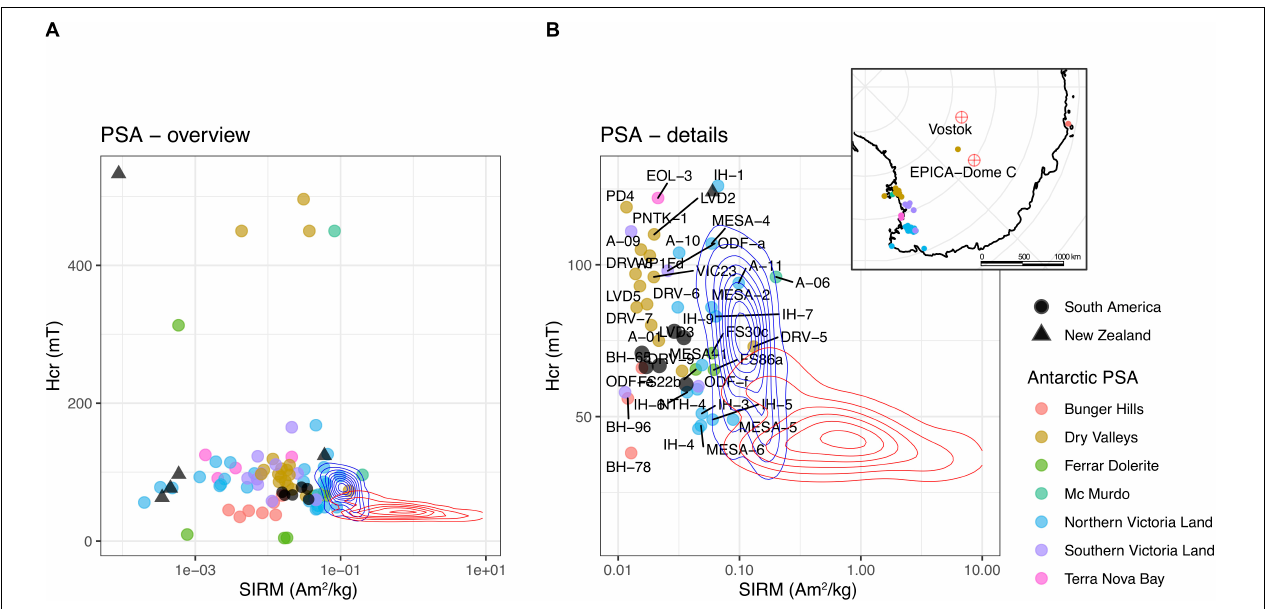
FIGURE 6 | Magnetic properties of PSA samples in the semi-logaritmic SIRM/H cr diagram. The SIRM dust data from ice cores, including the dataset from Lanci et al. (2008a), are reported for comparison using their distribution density estimates computed according to Venables and Ripley (2002). SIRM dust data are divided in glacial (IDC ≥ 100 ng/g) and interglacial (IDC < 100 ng/g) groups whose distribution is indicated with blue and red lines, respectively. Isolines shows the same level of density of SIRM dust data. The whole dataset used to compute the distribution is available in the Supplementary Material . (A) All available PSA samples divided in groups based on provenance area. (B) Close-up view of the PSA samples that shows properties similar to that of ice dust. Information on individual PSA samples can be found in the Supplementary Information . Despite the large natural variability of magnetic properties of PSA samples, none of them can explain the properties of interglacial aerosol dust.